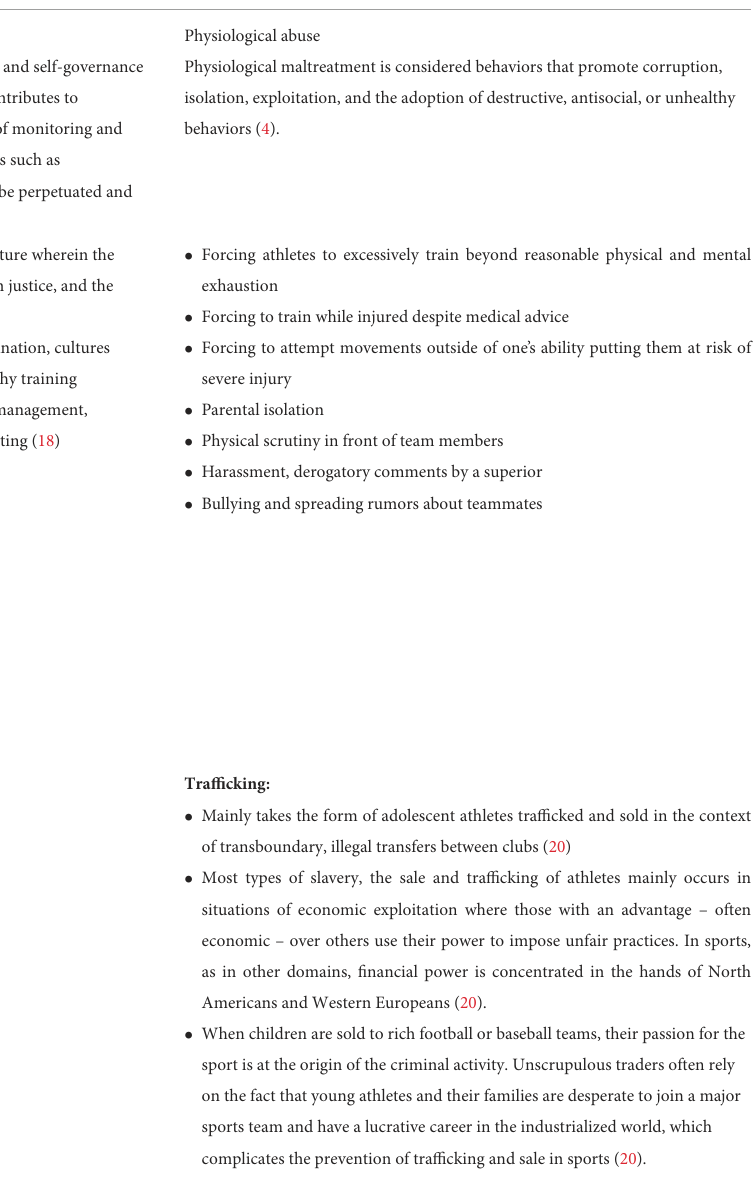
TABLE 2 Non-relational maltreatment.